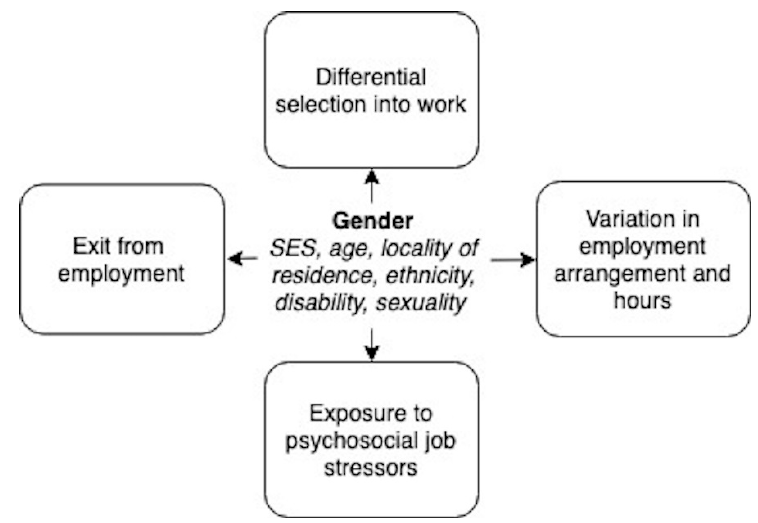
Figure 1. Conceptualisation of gendered working environments.